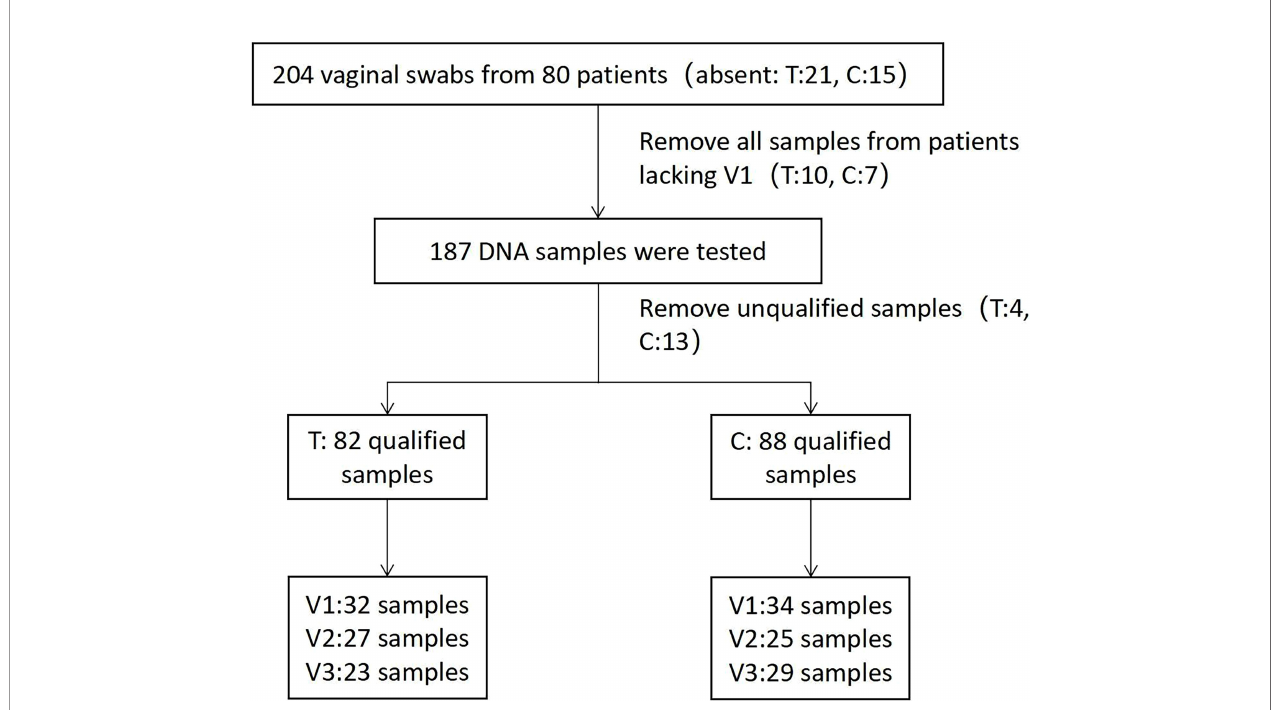
FIGURE 2 | Flowchart of Accu16S quali fi ed sample screening.